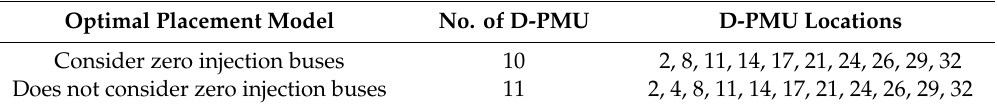
Table 3. E ff ect of zero injection buses on placement results. Table 3. Effect of zero injection buses on placement results